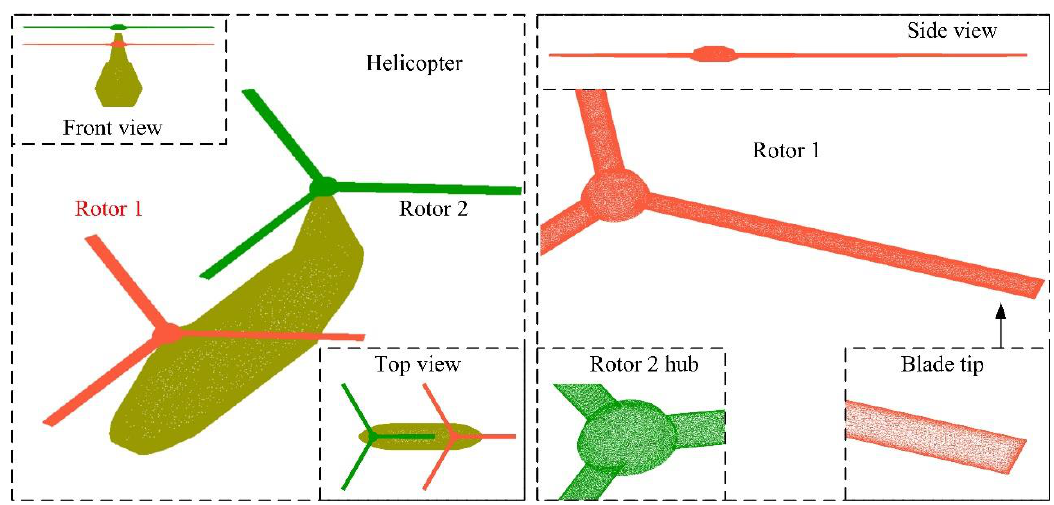
Figure 5. High-precision mesh on the surface of the helicopter